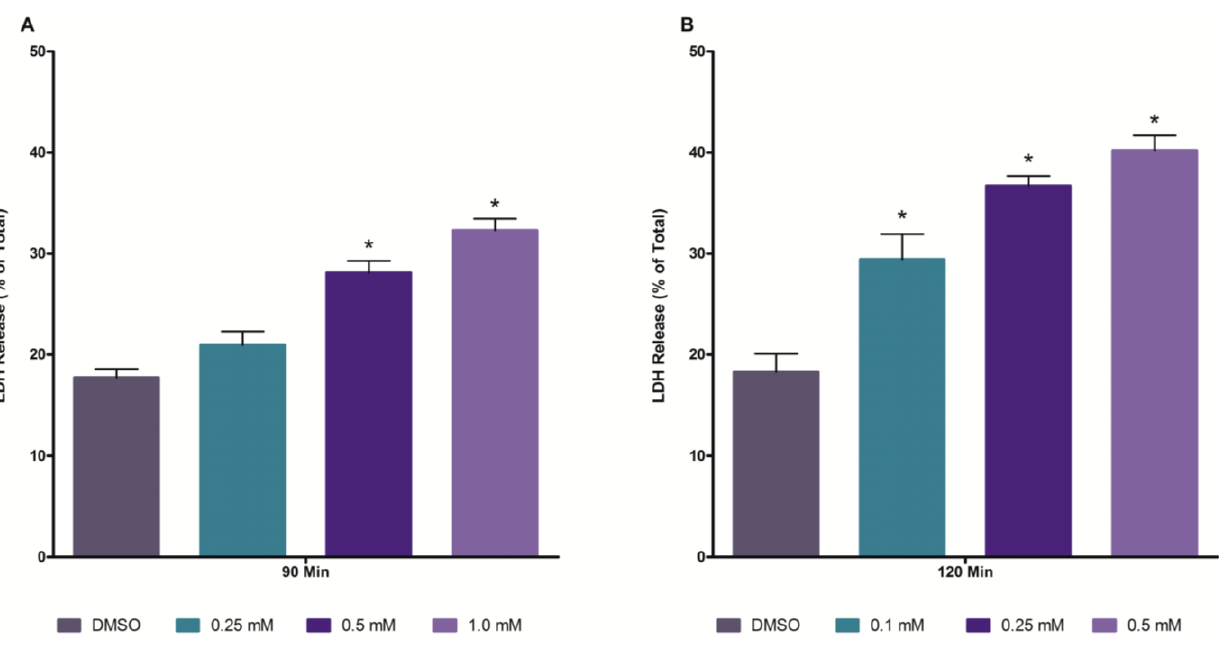
Figure 1. Cytotoxic effects of TCA at 90 min ( Panel A ) and 120 min ( Panel B ) in isolated renal cortical cells (IRCC). An asterisk indicates significantly different from the dimethyl sulfoxide (DMSO) control group value, p <